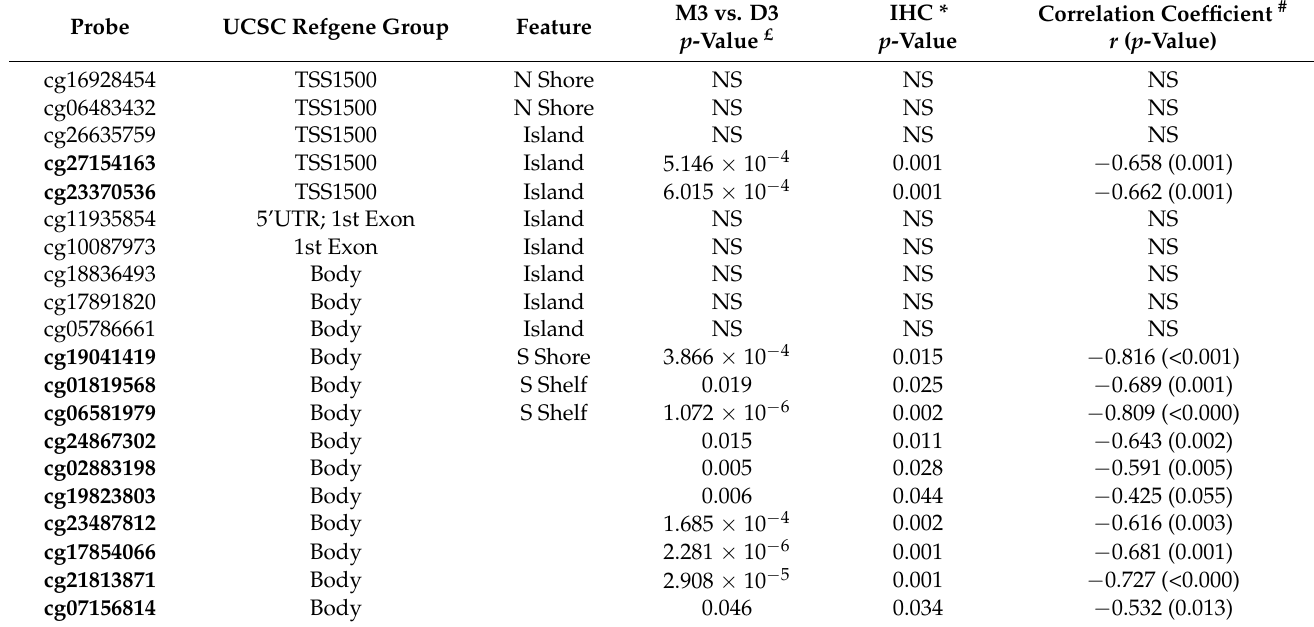
Body £ Difference between M3 and D3 gene expression data; * difference in methylation β values between KIT negative and positive tumors according to t-Test or Mann–Whitney U-test, respectively; # correlation between absolute signal intensity mRNA and methylation β values in individual positions. For each probe, the CpG feature and probe ID are listed; differentially methylated probes are in